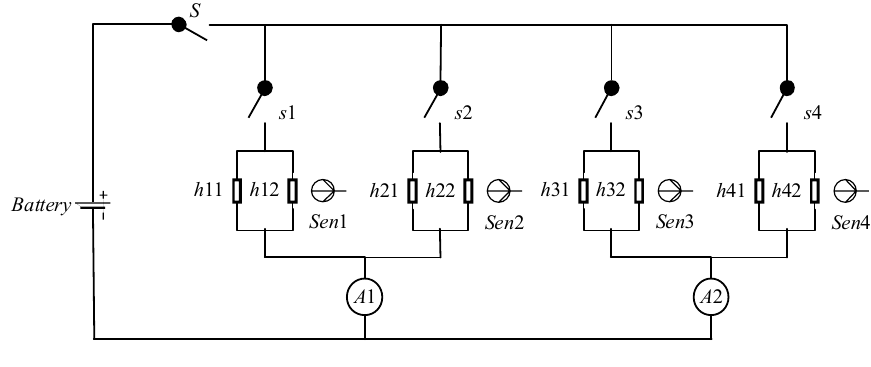
Figure 13. Heat Control System.